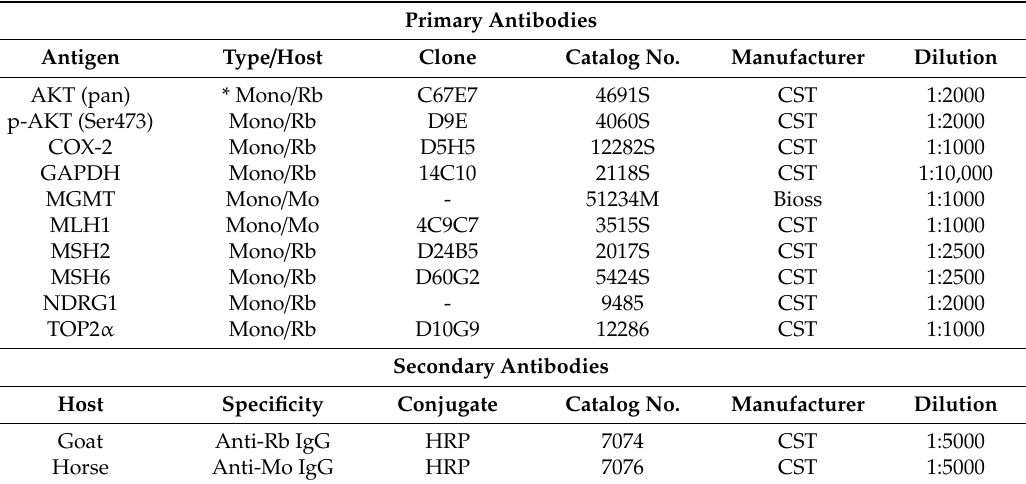
Table 4. Primary and secondary antibodies used in this